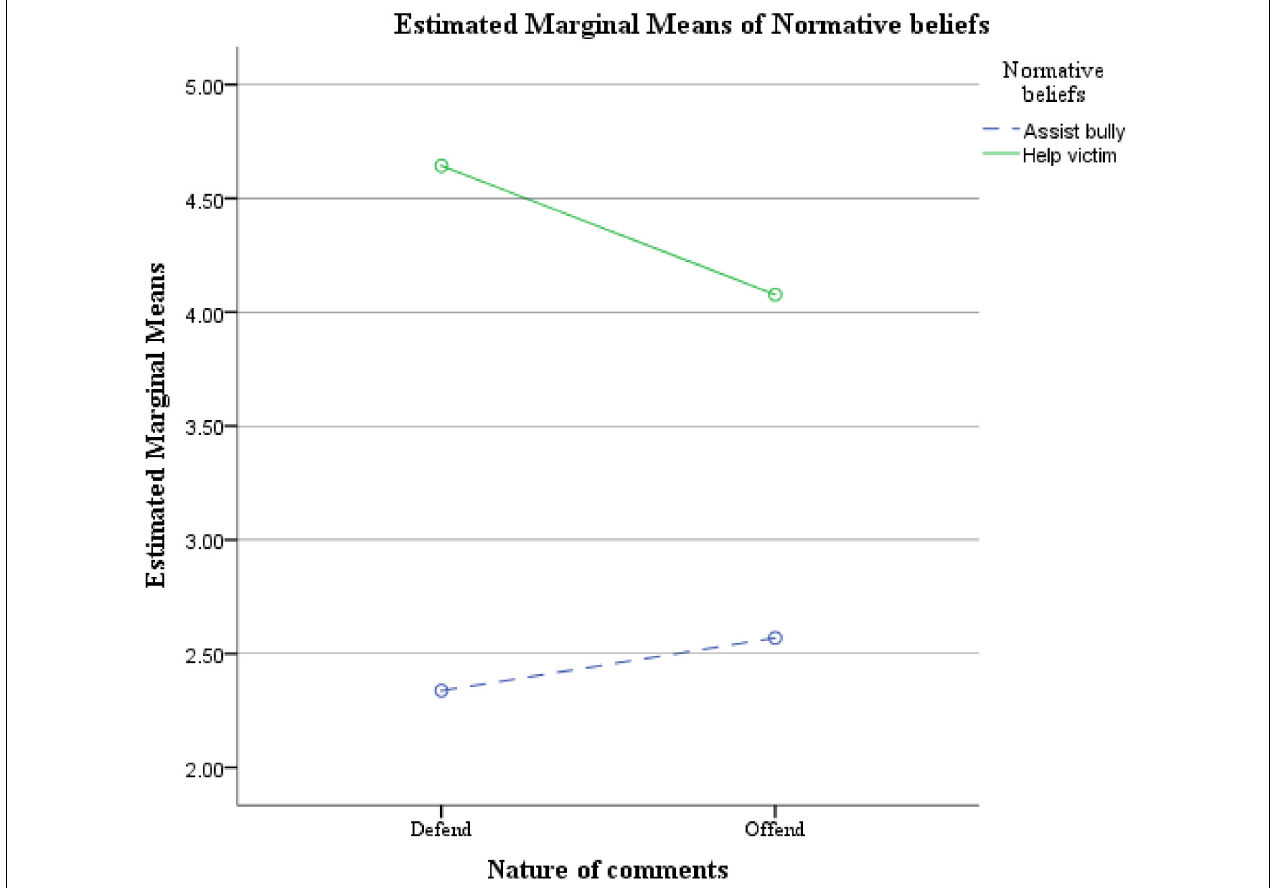
FIGURE 5 | Estimated marginal means of the 2-way interaction between defend/offend condition and type of normative beliefs about bystander